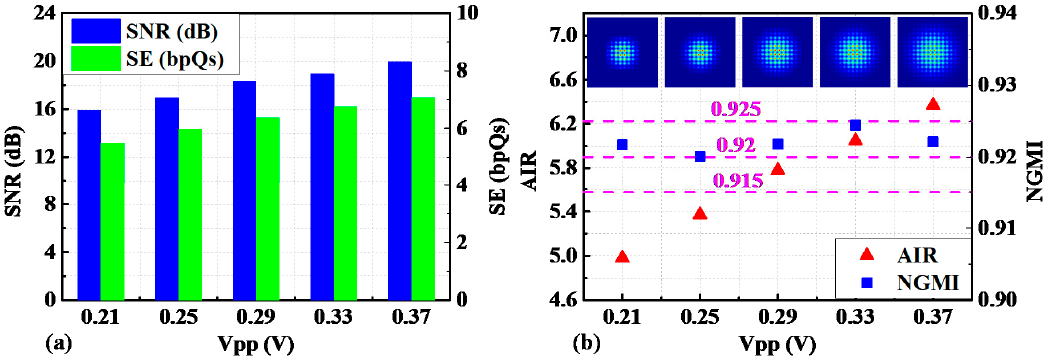
Figure 9. Experimental results at the NGMI threshold 0.92.